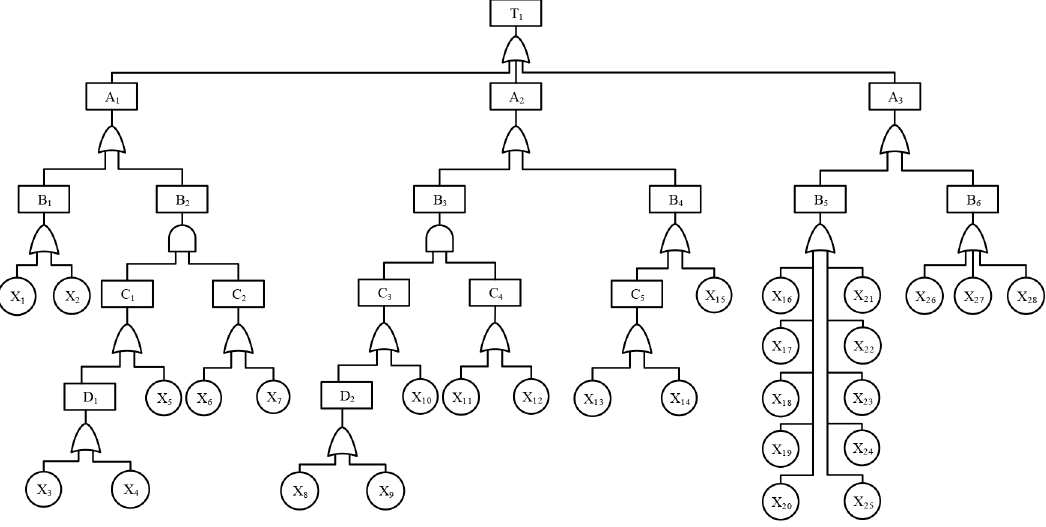
Figure 8. Fault tree of the safety organization management subsystem